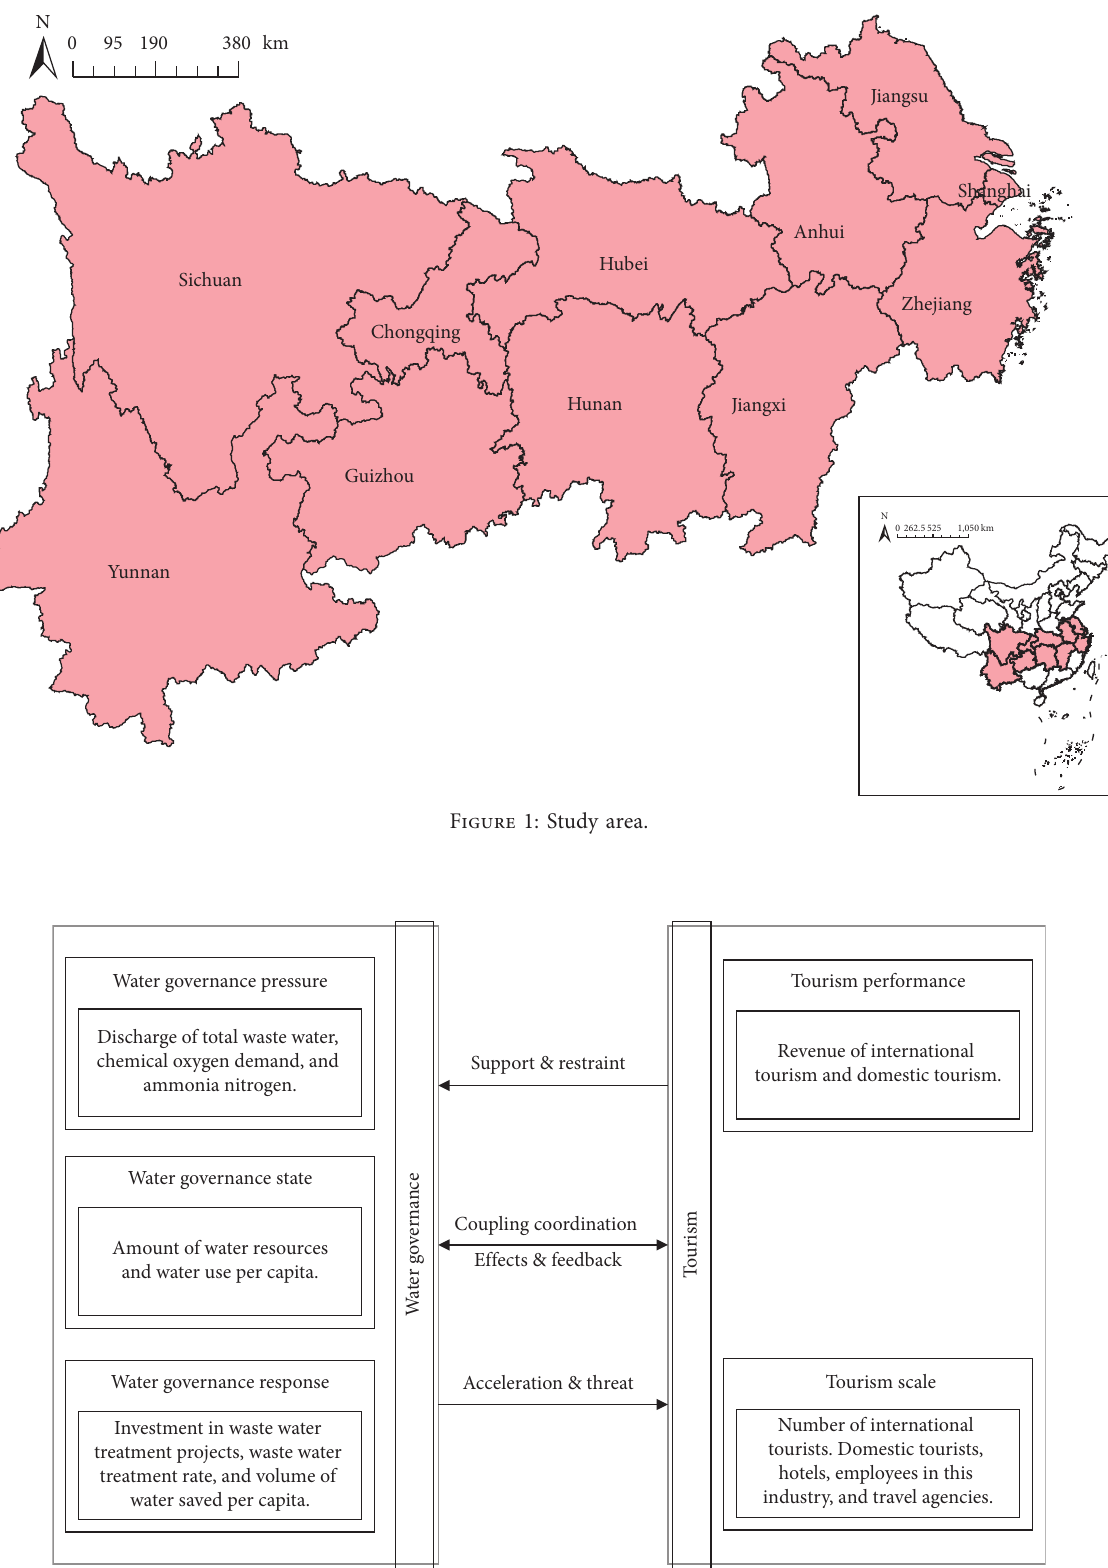
Figure 2: Correlation mechanism of water governance-tourism system.